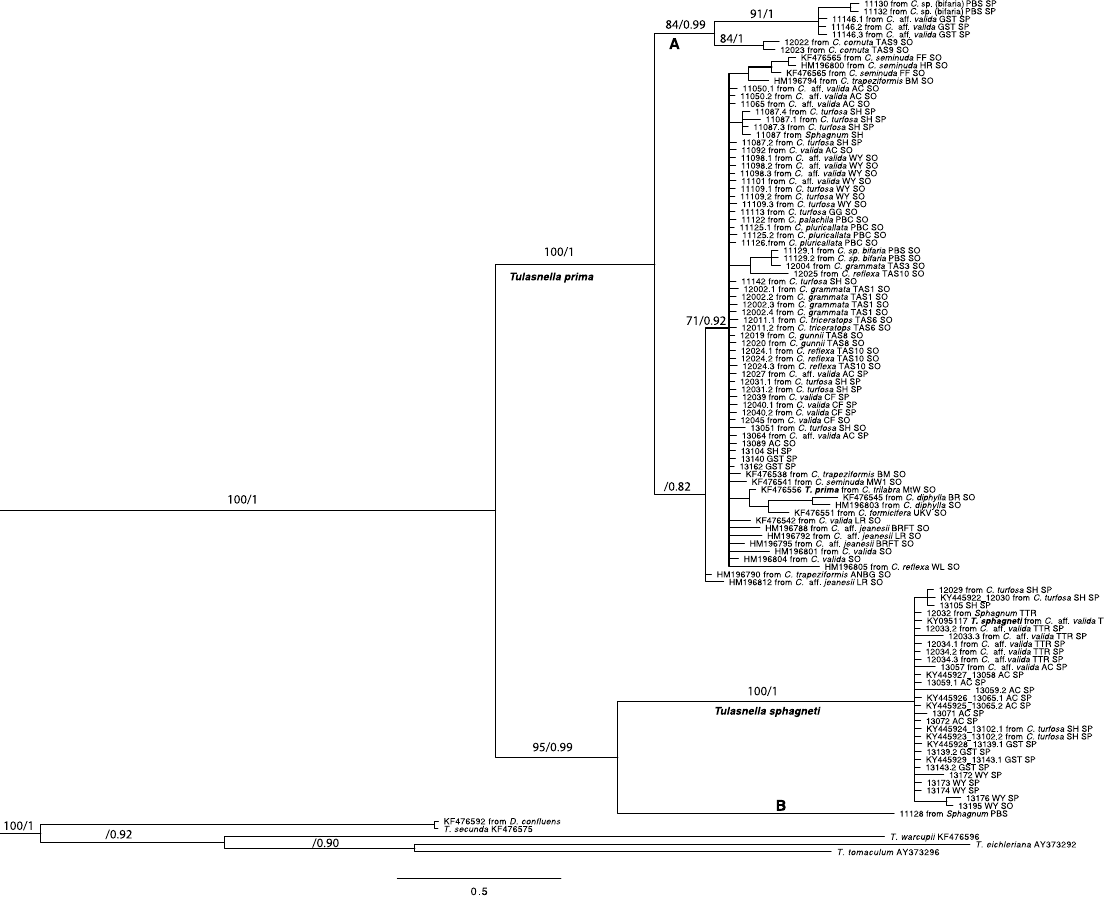
Figure 1. Maximum likelihood of ITS sequences from fungal isolates associated with Chiloglottis species. Bayes posterior probability values and bootstrap values are shown. Only posterior probability values > 0.70 and bootstrap values > 0.80 are shown. For pictorial brevity not all isolates used to compute the posterior probability and bootstrap values were included in the tree. Isolates from the clade representing Tulasnella prima were removed from the tree; these isolates were duplicate or representatives isolates taken from the same site and orchid species shown in the tree. Furthermore, Tulasnella secunda isolates as well as isolates from Arthrochilus oreophilus were removed from the tree for pictorial